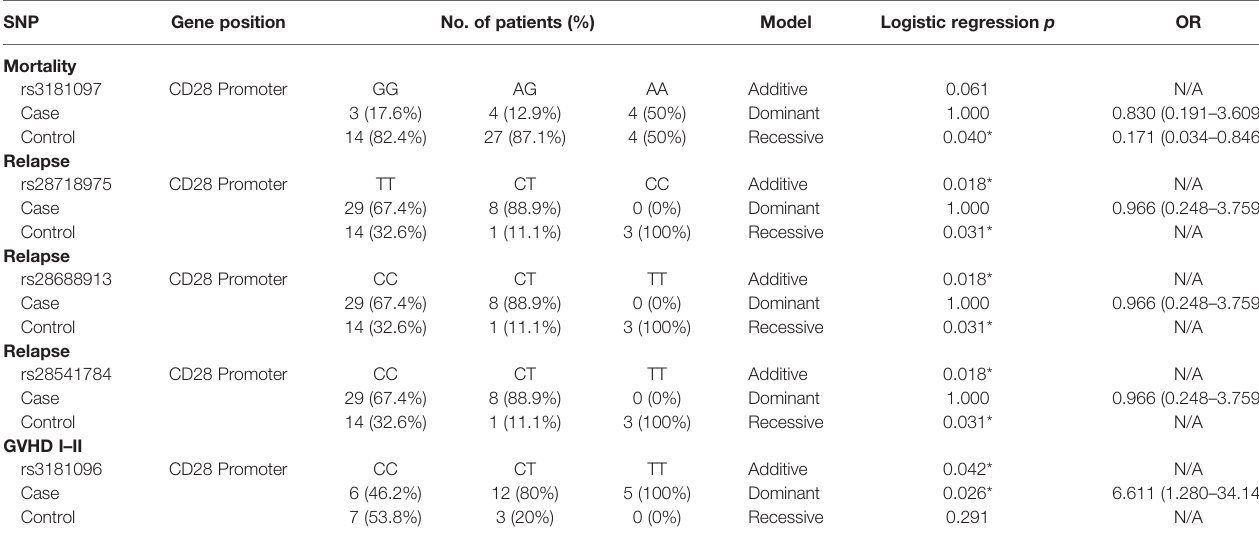
TABLE 4 | The SNPs in the CD28 gene associated with the outcomes of